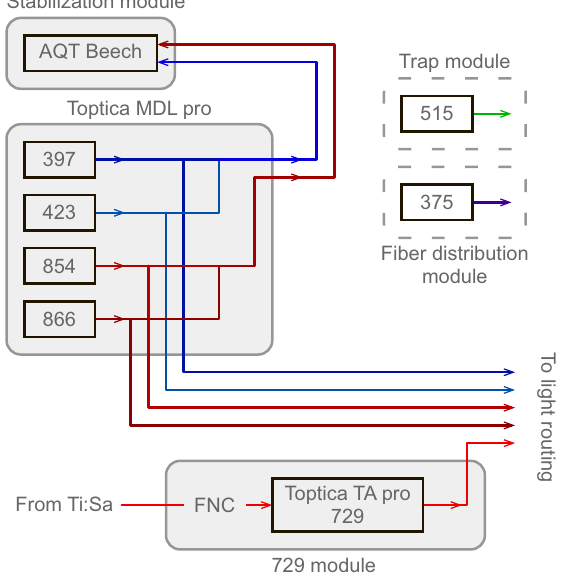
FIG. 4. Schematic of the principal light generation modules. A modified Toptica MDL pro unit produces four of the five laser colors needed for incoherently driven excitations. Their output is fiber coupled to a frequency stabilization module. A free-running laser diode is additionally installed downstream to provide the final incoherent excitation color. Laser colors within the qubit manifold are generated by a Toptica TA pro seeded by light from an ultrastable MSquared SolsTiS Ti:Sa master oscillator present in the